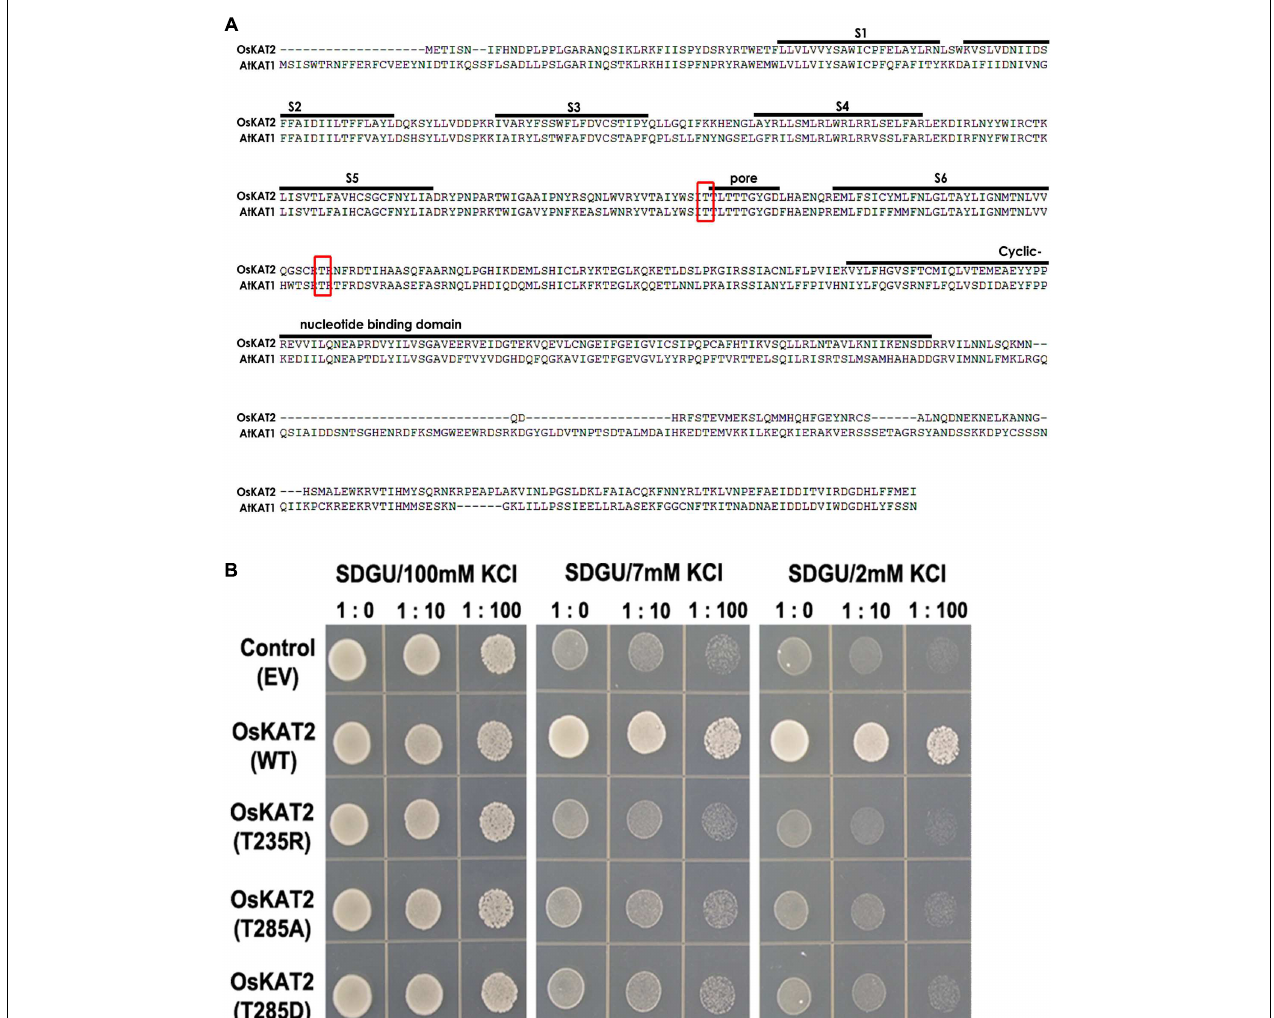
FIGURE 1 | Amino acid sequence comparisons of OsKAT2 and AtKAT1 proteins, and complementation analysis of OsKAT2 mutants using potassium uptake-deficient yeast. (A) The consensus TxxTxGYG motif in the K + -selective pore-forming loop region is labeled “pore.” The regions indicated by solid lines are putative transmembrane domains (S1–S6). The red box represents the positions of the single amino acid mutations in OsKAT2. (B) The CY162 yeast strain was transformed with empty vector (EV, pYES-DEST52), OsKAT2 (wild-type) and OsKAT2 single amino-acid mutant (T235R, T285D, and T285A). Ten-fold serial dilutions of yeast cell suspensions were spotted onto solid SDGU medium containing 2, 7, or 100 mM KCl. Accession numbers are follows: OsKAT2, XP015614100; AtKAT1,